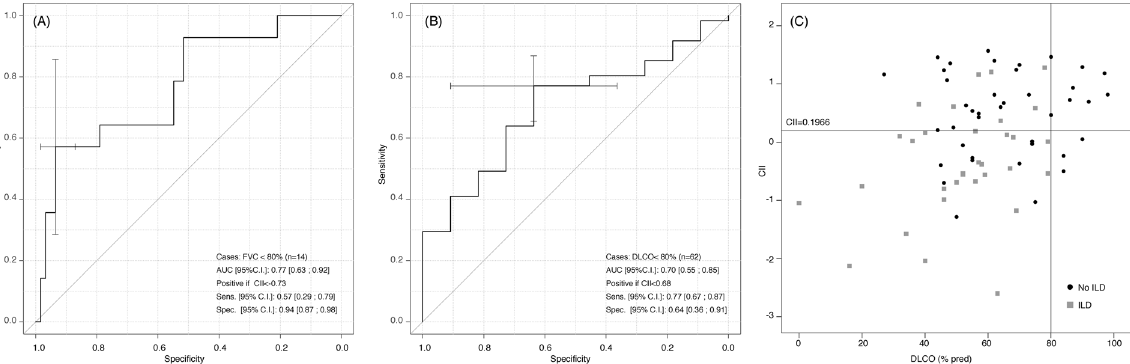
Figure 2. ( A , B ) Diagnostic accuracy of the CII according to baseline values of FVC ( A ) and DLCO ( B ) by means of receiver-operating characteristic curve analysis. ( C ) Scatter plot of CII and DLCO values stratified according the presence of ILD. 0.1966 was the cut-off value obtained by analyzing the diagnostic accuracy of the CII (see Fig. 1, panel E). CII = computerized integrated index; FVC = forced vital capacity; DLCO = diffusing lung capacity for carbon oxide; ILD = interstitial lung disease; AUC = area under the curve; CI = confidence interval.